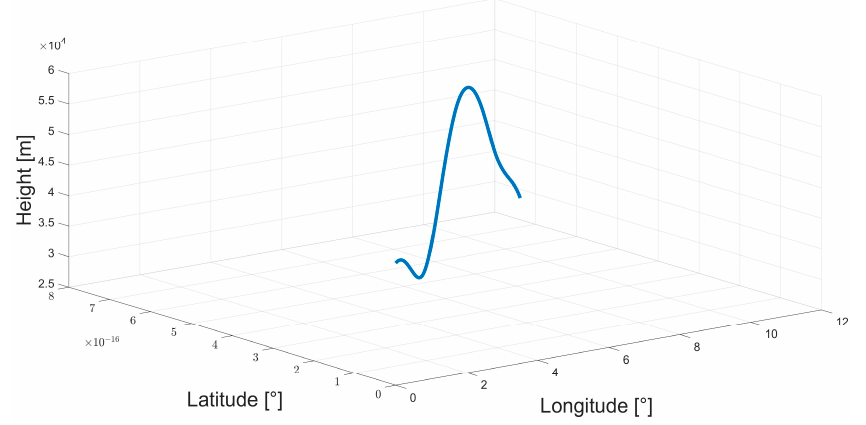
Figure 10. The skip-gliding trajectory of the non-cooperative target.